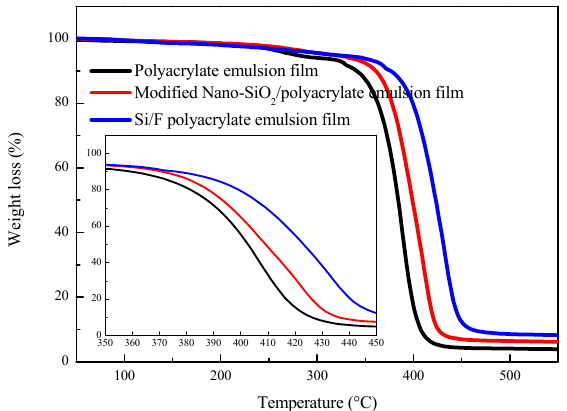
Figure 7. Thermal gravimetric curves of polyacrylate emulsion film, modified Nano-SiO 2 /polyacrylate emulsion film, and Si/F polyacrylate emulsion